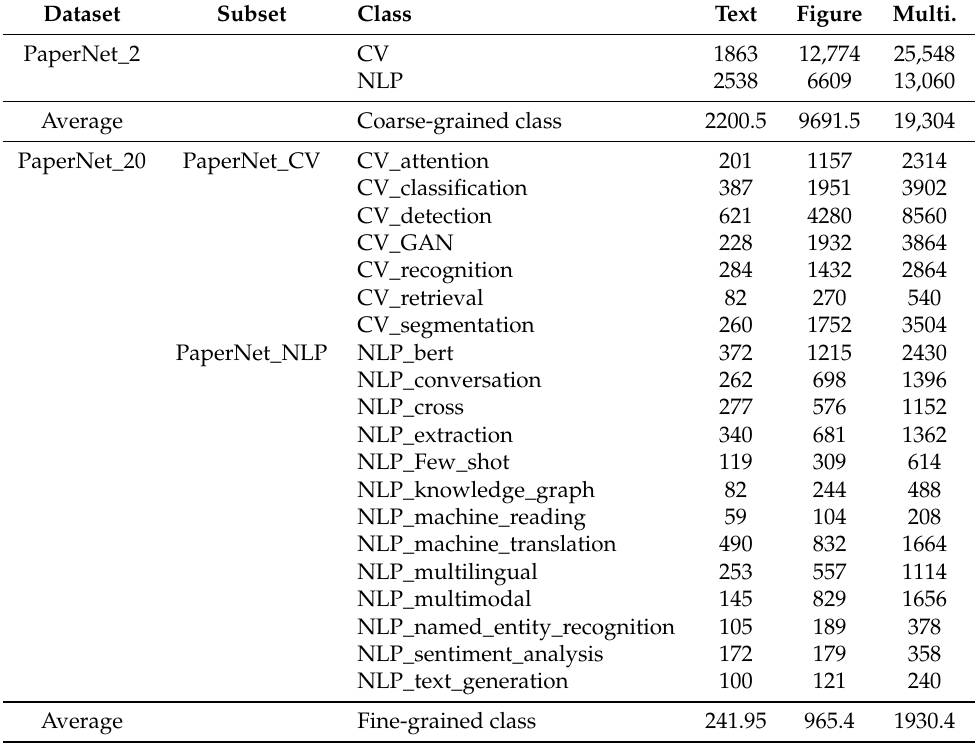
Table 2. Details of PaperNet datasets (Multi. means the pre-processed multimodal data).